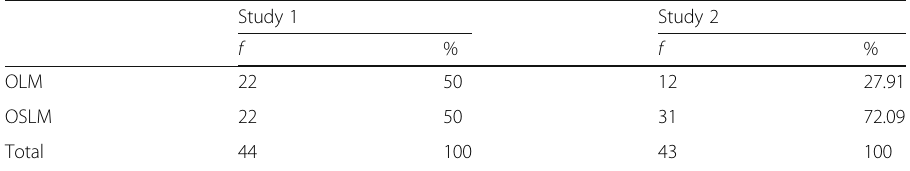
Table 1 Descriptive statistics of the participants Study